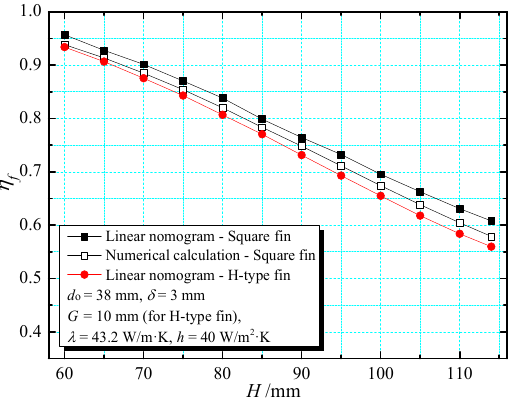
Figure 10. Influence of the fin height on the fin efficiency of H-type and square fins.